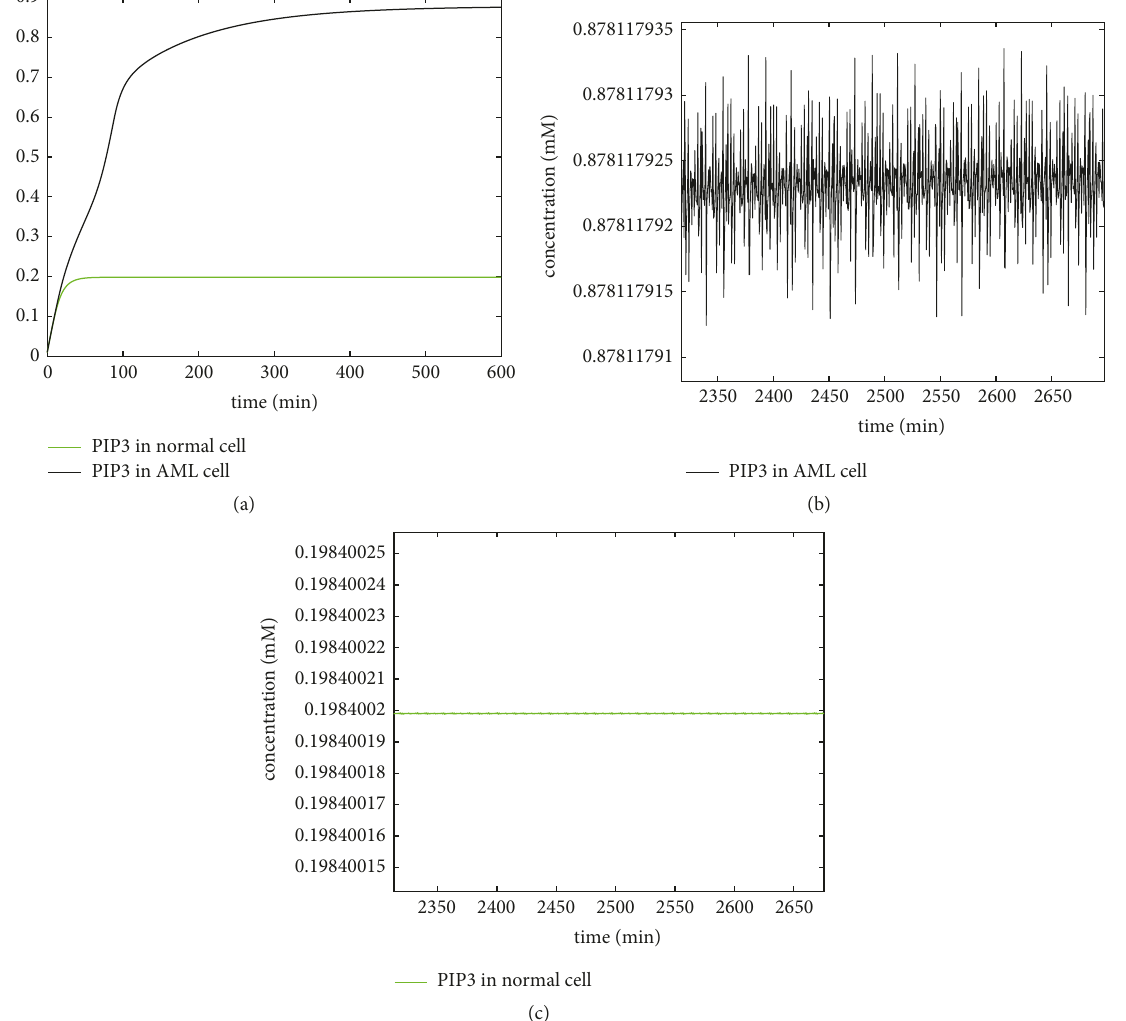
Figure 5: Dynamics of PIP3 in the normal cell and AML cell (a). Concentration of PIP3 in AML cell oscillates at a certain level (b), while PIP3 in normal cell does not oscillate